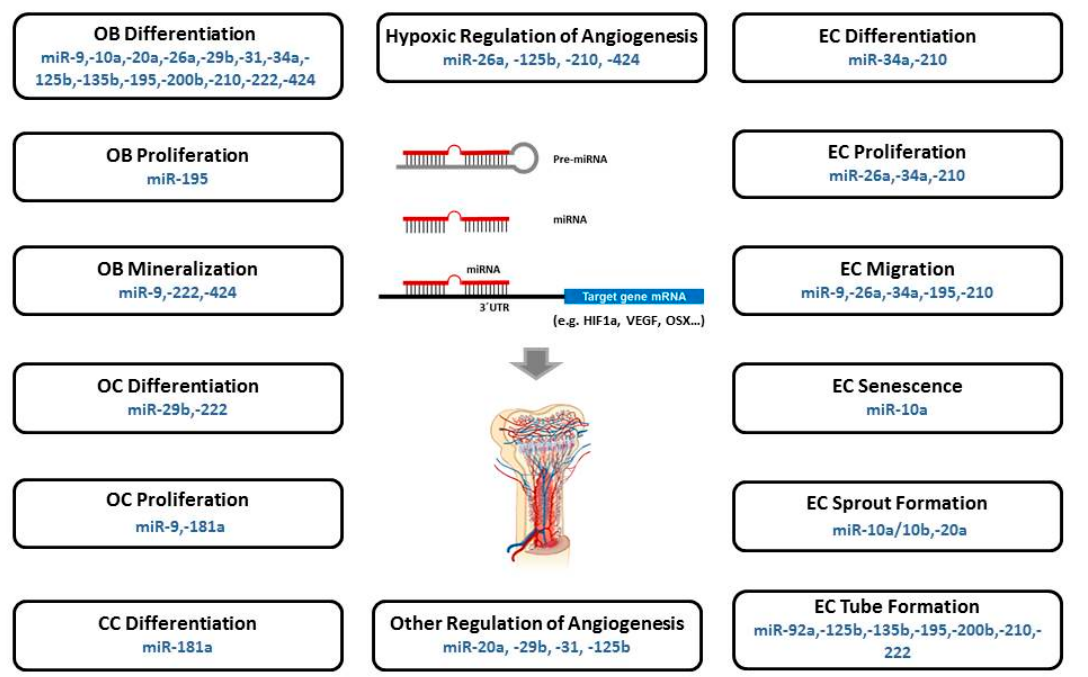
Figure 1. MicroRNAs (miRs/miRNAs) involved in the regulation and coupling of bone angiogenesis (“CouplingmiRs/CPLGmiRs”). Reported miRNAs contributing to the formation of blood vessels during the processes of formation, repair and regeneration of bone were allocated with the individual functions of their target genes during osteogenesis, angiogenesis, or hypoxic regulation of bone angiogenesis. OB, osteoblast; OC, osteoclast; CC, chondrocyte; EC, endothelial cell.